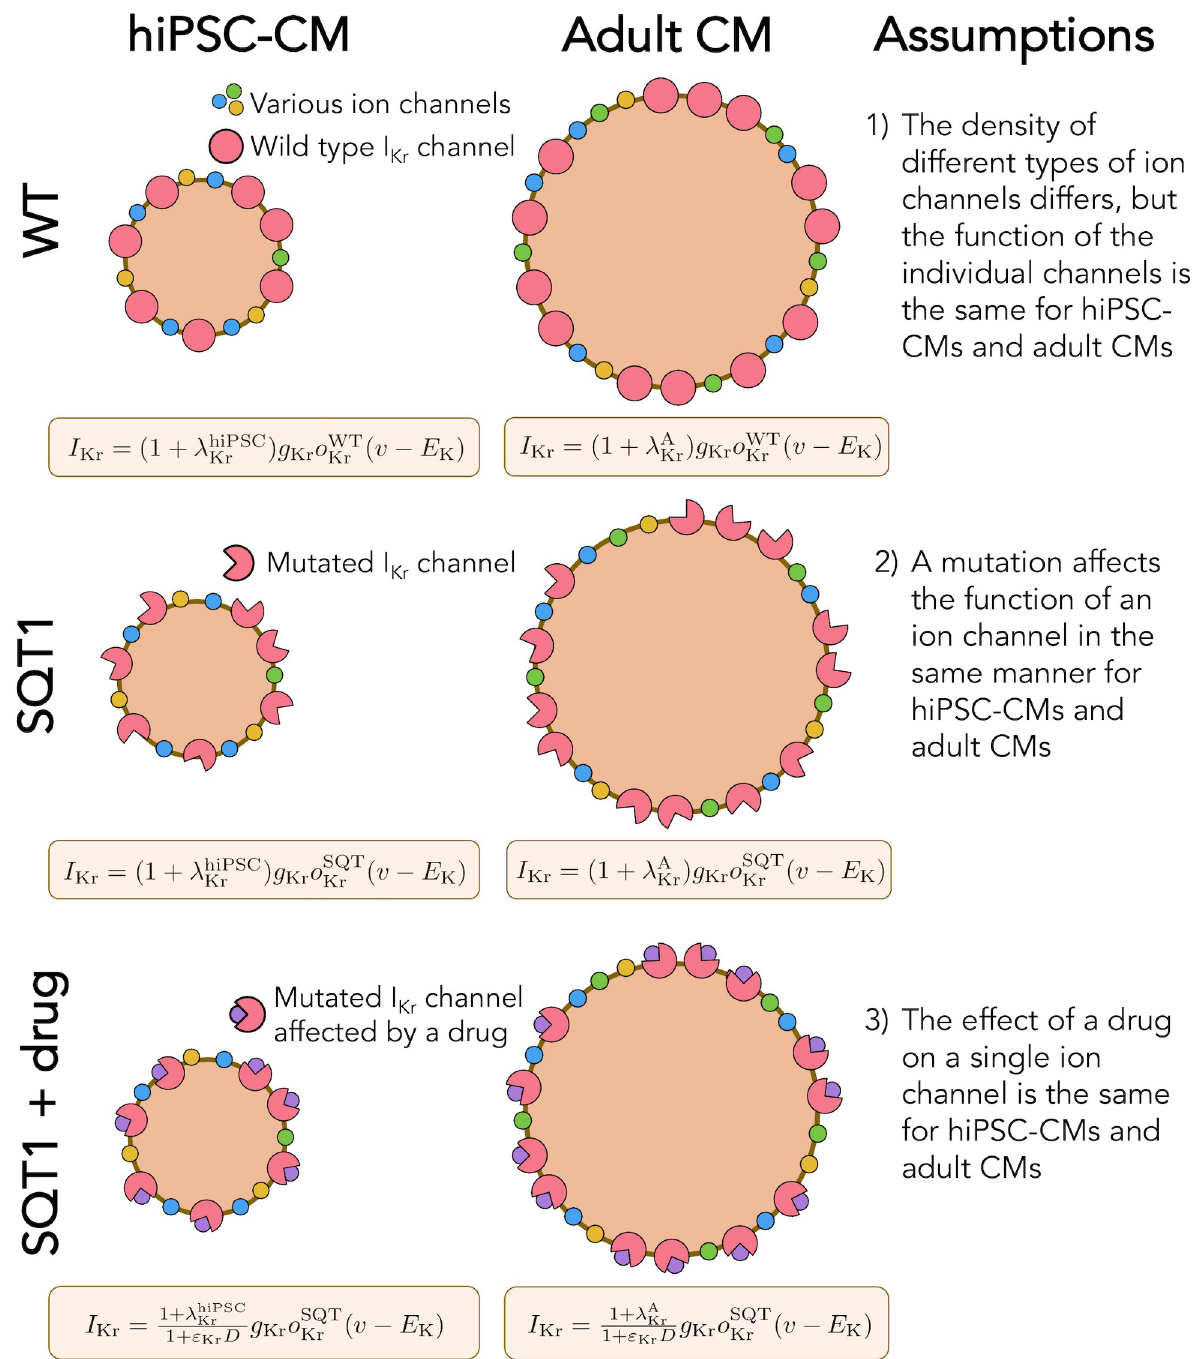
Fig 2. Illustration of the assumptions underlying the computational maturation approach. 1) The density of different types of ion channels (and other membrane or intracellular proteins) may differ between hiPSC-CMs and adult CMs, but the function of the individual channels is the same. In the model, the density difference is represented by the parameter λ . 2) The SQT1 mutation affects the individual I Kr channels in exactly the same manner for hiPSC-CMs and adult CMs. In the model, the mutation is represented by an adjusted model for the open probability, o Kr . 3) The effect of a drug on a single protein is the same for hiPSC-CMs and adult CMs. In the model, the drug effect is represented by the parameter ε .